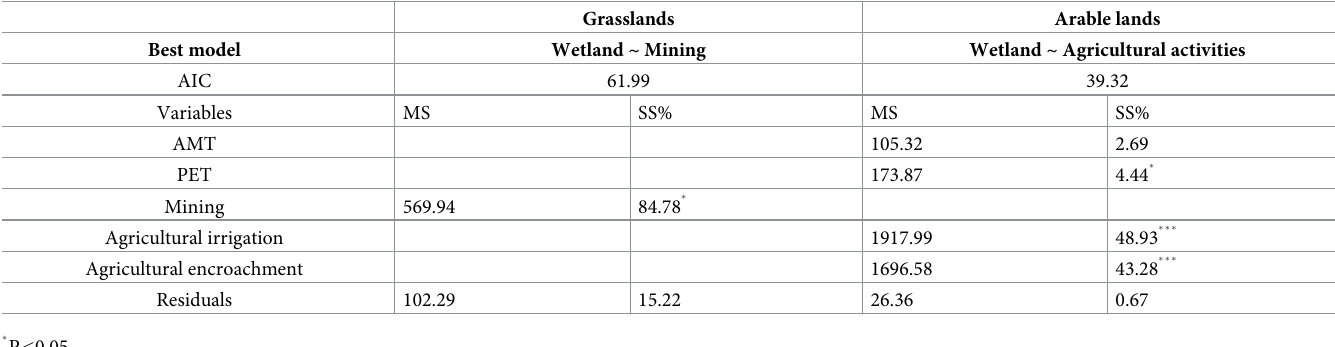
Table 5. Best models selected by Akaike Information Criterion and generalized linear model between wetland and selected variables by Akaike Information Crite- rion for different regions in IMAR.